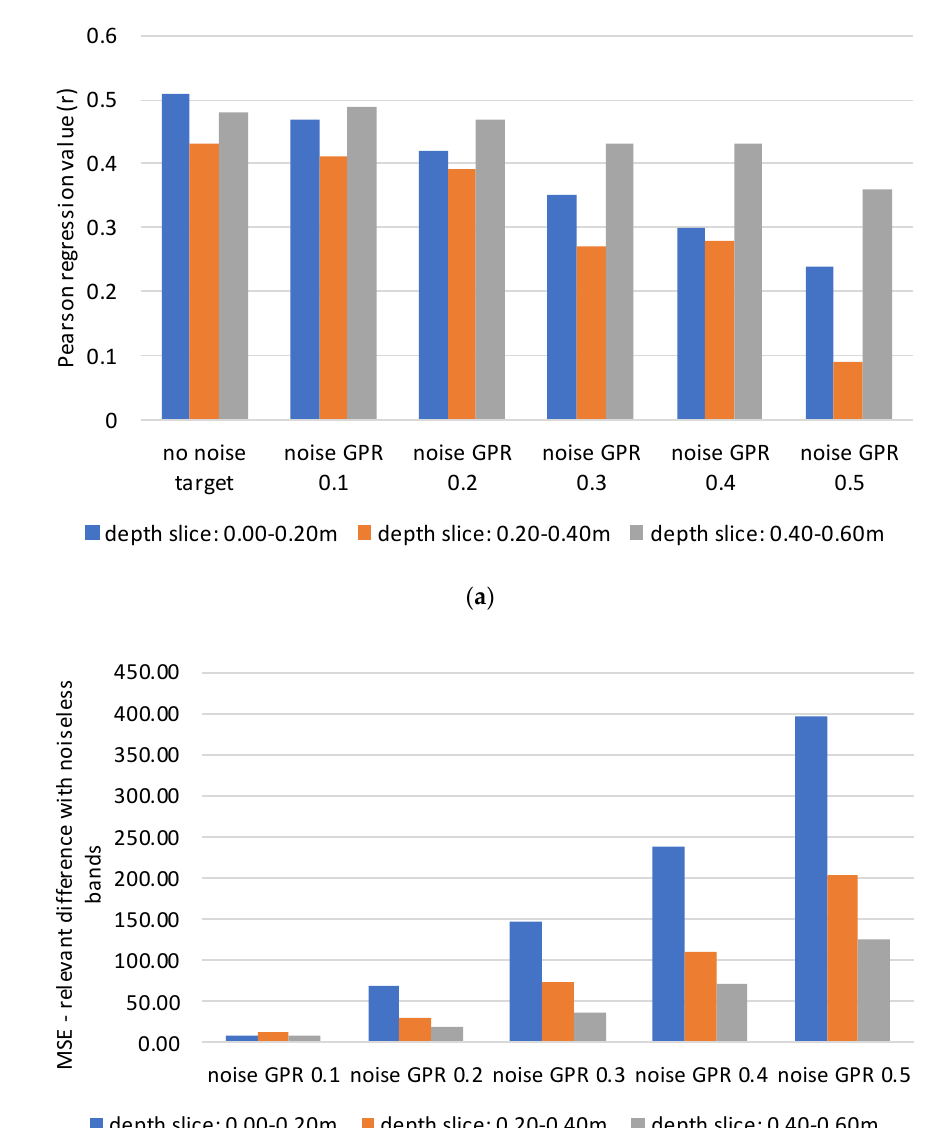
Figure 6. ( a ) Pearson regression value ( r ) of the fusion between the GPR depth slices and the four bands based on the Bayesian Neural Network. ( b ) Relative difference (%) of the Mean Square Error (MSE) of the noisy data of 0.1–0.5 standard deviation against the noiseless datasets. GPR depth slice of 0.00–0.20 m is shown with blue color, depth slice of 0.20–0.40 m with an orange color and depth slice of 0.40–0.60 m depth slice with a gray color.